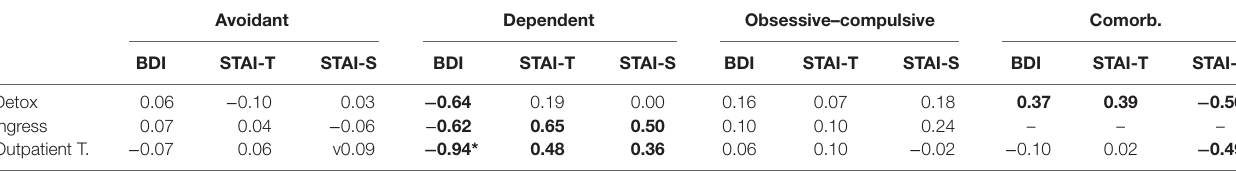
Table 5 | Relationships among depression/anxiety and treatment keys in Cluster C. avoidant Dependent Obsessive–compulsive comorb.